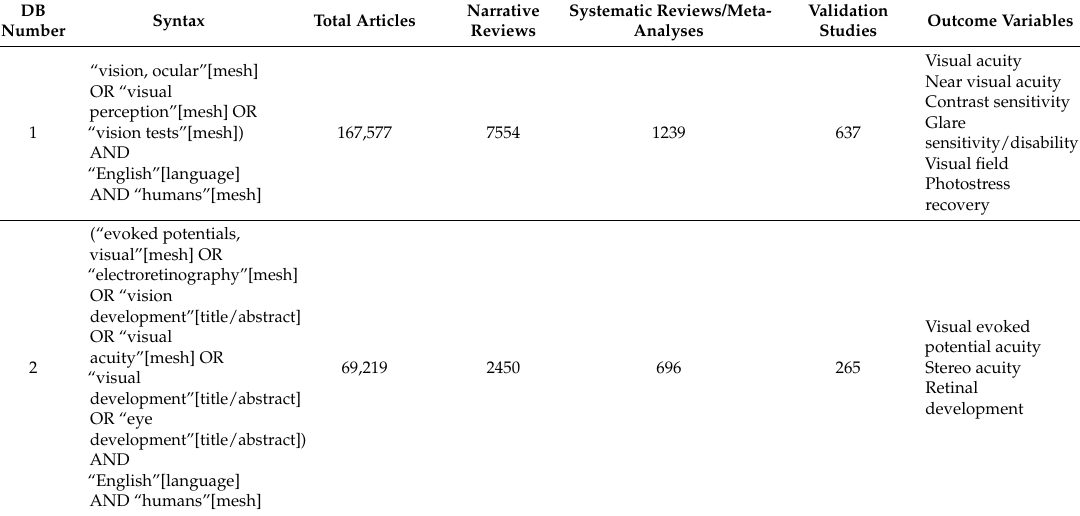
Table 1. Strategies used for retrieving the literature pertinent with outcome variables and methods of measurement related to cognitive function in